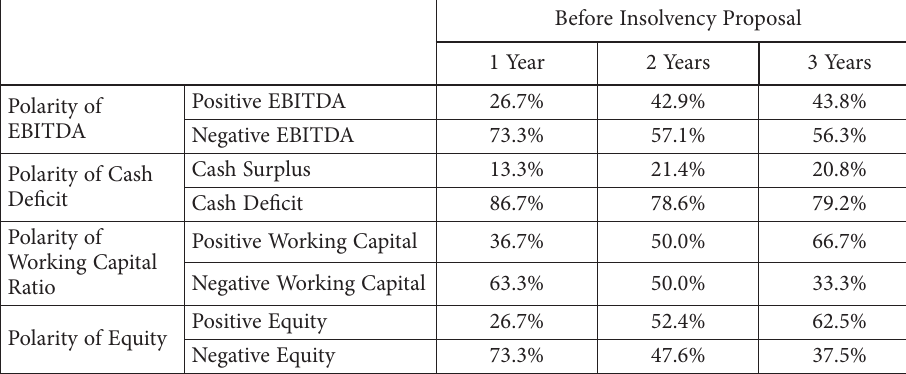
Table 4. Relative polarity of frequencies of selected indicators(source: author based on Bisnode Mag-